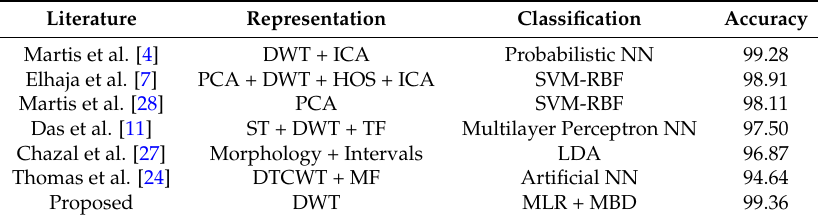
Table 19. Performance comparison of ECG classification